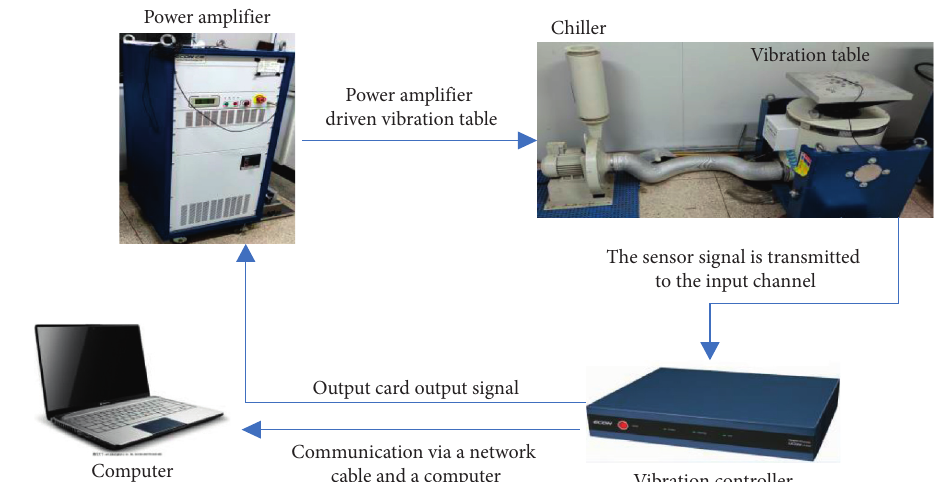
Figure 21: Instrument